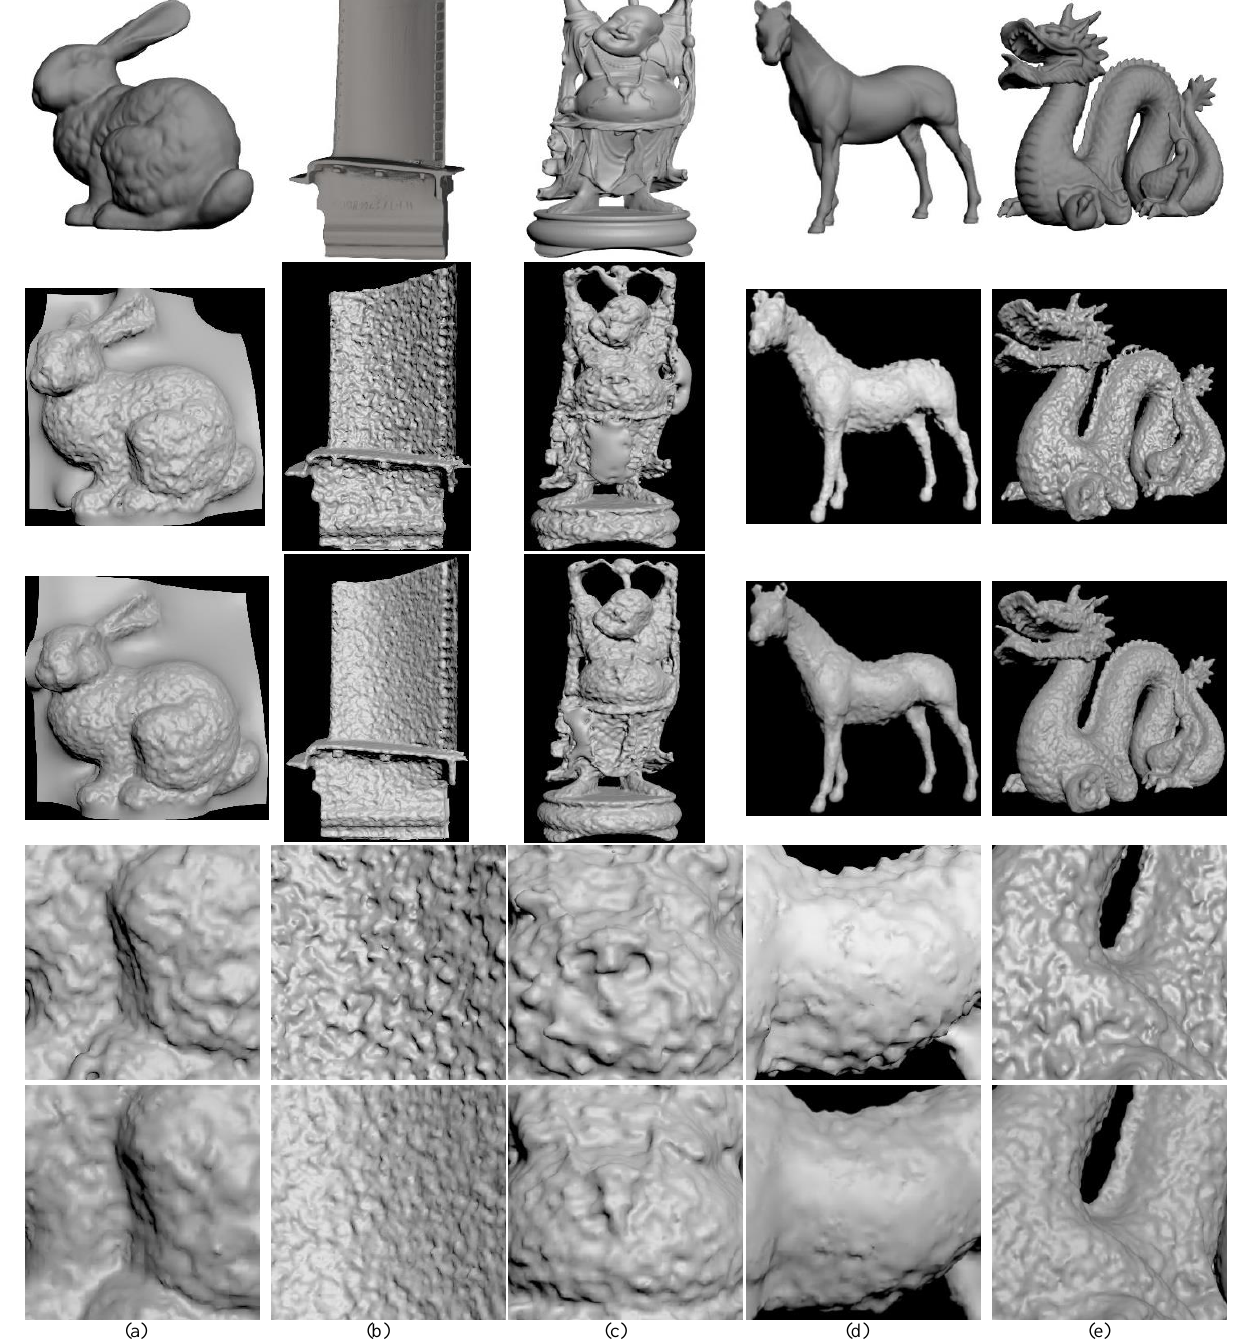
Figure 6. Columns from left to right (a) the Stanford Bunny [16] (b) the Turbine Blade [17] (c) the happy Buddha [16] (d) the Horse [17] and (e) The dragon [16]. The first row is the original models. The second row is the reconstruction for rectified setup. The third row shows reconstruction for optimized setup. The fourth and fifth rows are a magnified part of rows two and three, respectively, to clarify improvement in surface reconstruction for given models after camera arrangement